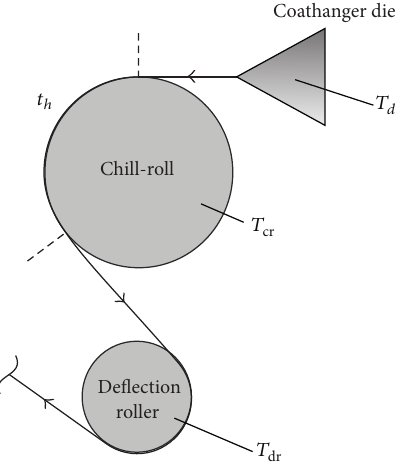
Figure 1: Schematical illustration of isothermal holding time during flat film extrusion ( 𝑡 ℎ = isothermal holding time, 𝑇 temperature, 𝑇 𝑑 = die temperature, and 𝑇